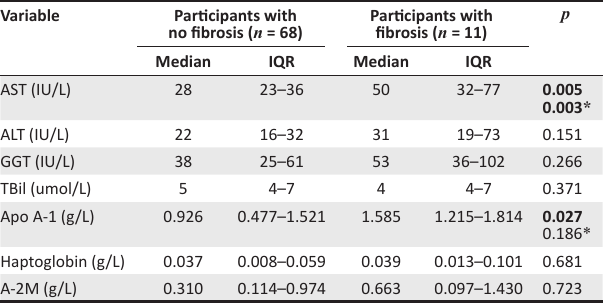
TABLE 4: Comparison of biomarkers in participants with significant fibrosis and those without as defined by the aspartate aminotransferase to platelet ratio index